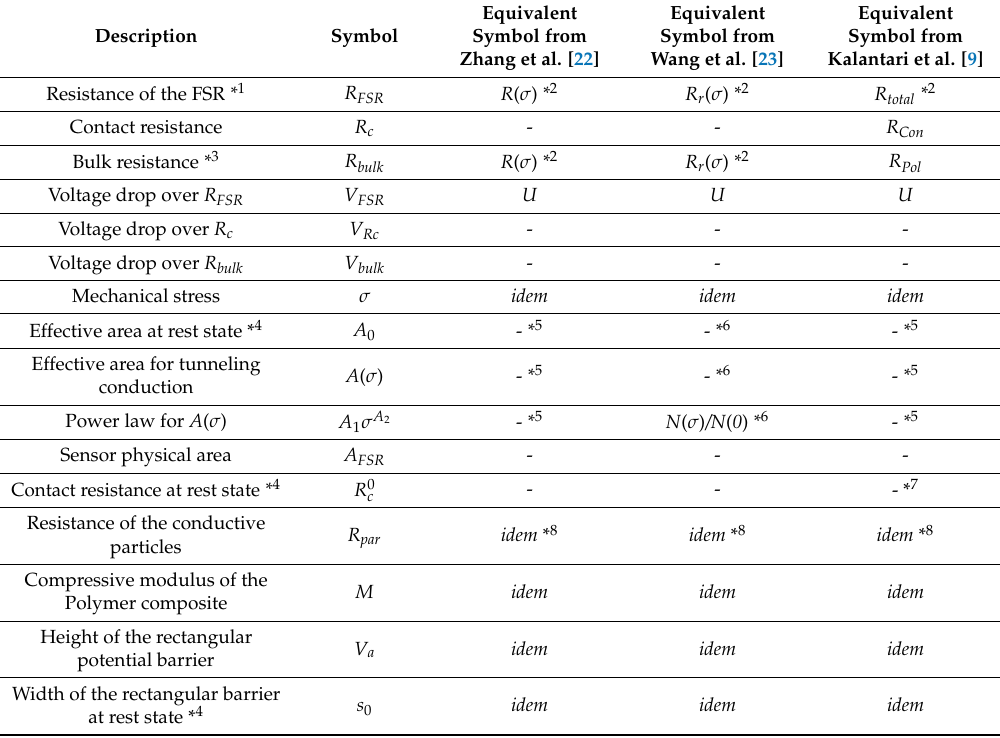
Table 1. Summary of the symbols employed in the proposed model. Comparison with similar studies is also